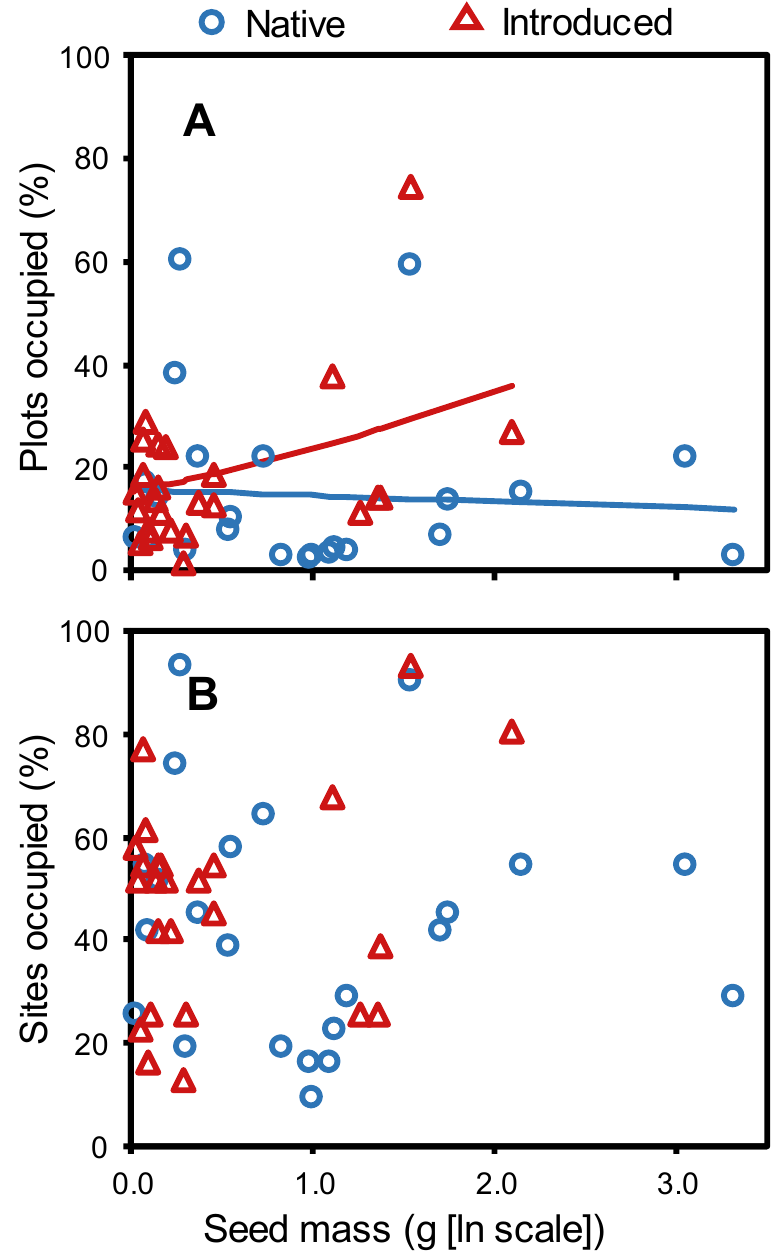
Figure 2. Relationship between seed mass (ln [mg + 1]) and species dispersion measured at two scales, as compared between 23 native and 25 introduced grassland species in Montana, USA. ( A ) At the local scale (proportion of plots occupied per site), the dispersion-seed mass relationship varied marginally by species origin when all species were tested together ( p = 0.067), with introduced species showing a positive relationship and native species trending in the opposite direction, as represented by solid lines indicating predicted probabilities. Note that the relationship was significant for introduced species when tested alone ( F 1,23 = 5.6, p = 0.027), but not for native species ( F 1,21 = 0.2, p = 0.69). ( B ) At the broad scale (proportion of sites occupied), dispersion did not vary with seed mass for either native or introduced species, whether tested together (see text) or separately by origin (native: F 1,21 = 0.1, p = 0.78; introduced: F 1,23 = 2.9, p = 0.1).